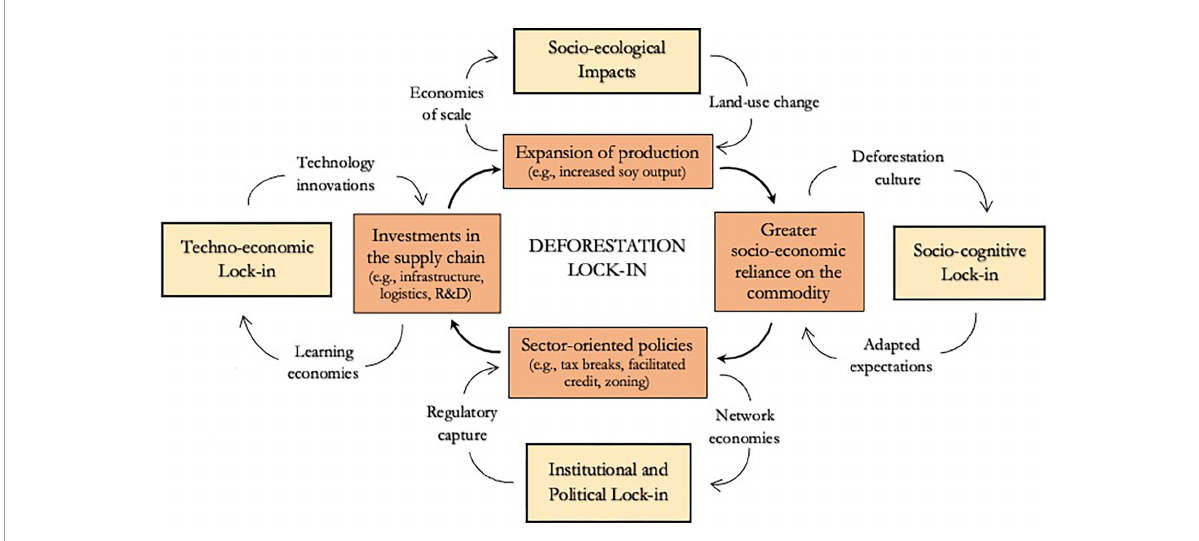
FIGURE1 An illustrative scheme of positive feedback loops creating a deforestation lock-in from the unsustainable expansion of an agricultural commodity. Adapted from Unruh (2000).